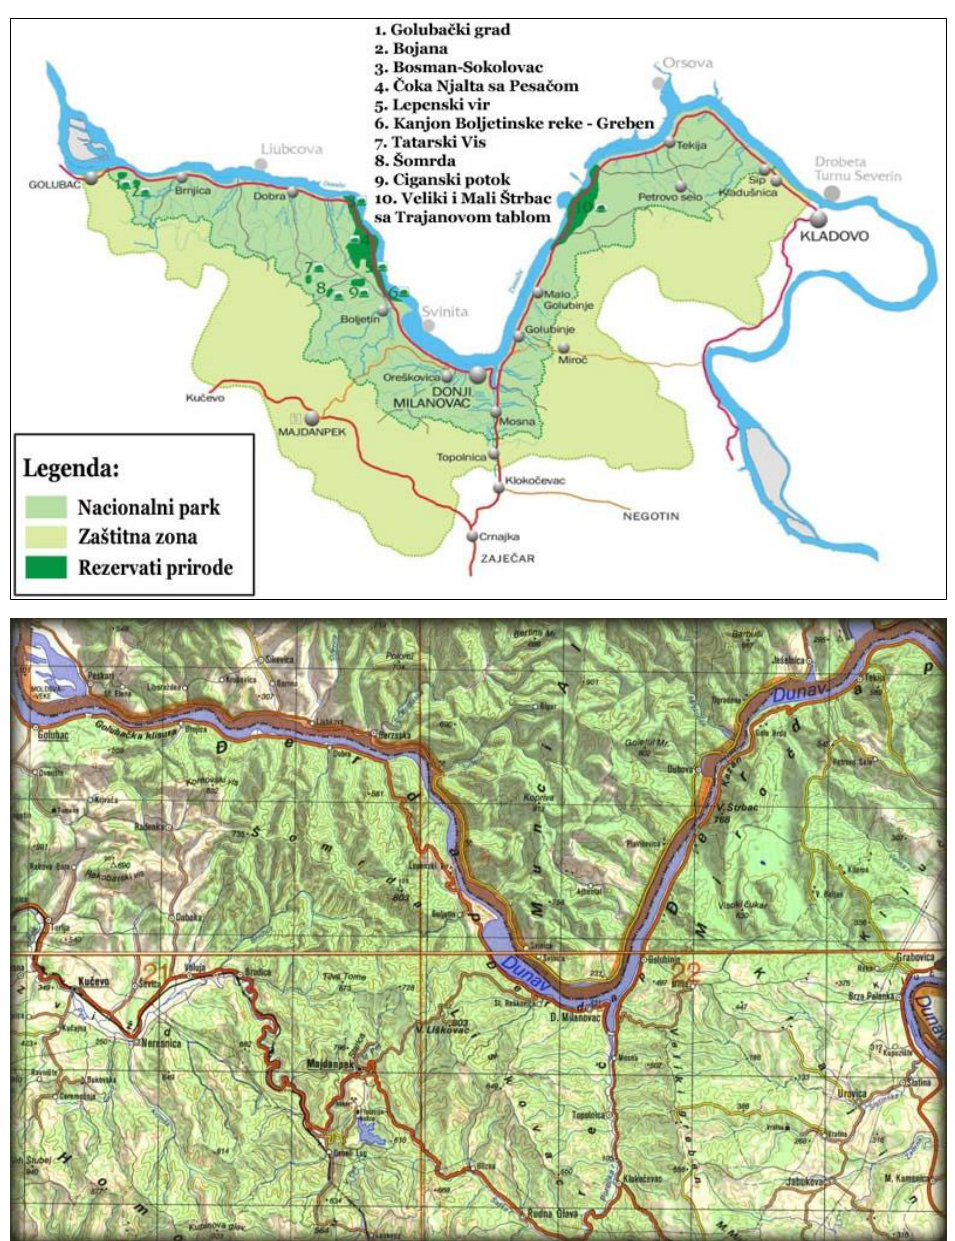
Figure 9. Location of the archaeological site and tourist settlement Lepenski Vir in the mountainous region of eastern Serbia placed on the banks of the Danube and the border with Romania 120 km east of Belgrade by air. The Đerdap Gorge consists of several distinct parts, with the extended parts regularly reappearing downstream, where the Danube is several kilometres wide, and the narrowing parts where there is less than 500m between two shores. Lepenski Vir is located at the place where the river is very narrow, about 600m. By the river, next to the site, the main road 34 leads, as well as the European mountaineering route E4. These modern roads certainly existed as logical connections even 8000 years ago, when the Lepenski Vir man just built a settlement here, and then in the time of the Romans (today's Dobra village, once the town of Gratiana, is listed as one of the towns on the Roman road Via Militaris). Circles on the map show the site and the proposal of the location of the new tourist